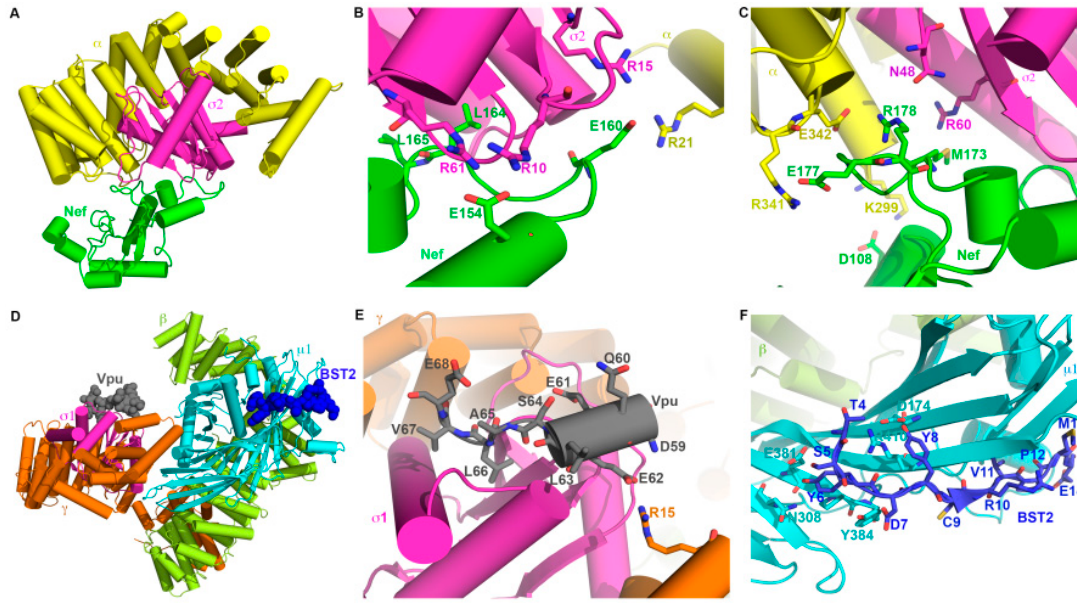
Figure 6. Structural interfaces between Nef and AP-2 (A–C) and Vpu, BST-2, and AP-1 (D–F). ( A ) Crystal structure of Nef bound to a hemi-complex of AP-2 containing two of the four AP subunits, α and σ 2 (PDB: 4NEE). α is shown in yellow; σ 2 is shown in magenta; and Nef is shown in green. ( B ) Interaction of Nef’s acidic leucine motif with α - σ 2. Nef L164 and L165 interact with σ 2 (magenta); Nef E160 interacts with R15 of σ 2 (magenta) and R21 of α (yellow); Nef E154 interacts with R10 and R61 of σ 2 (magenta). ( C ) Interaction of Nef distal C-terminal loop (173-178) with α - σ 2. Nef M173 interacts with R60 of σ 2 (magenta); Nef E177 interacts with R341 of α ; and Nef R178 interacts with E342 of α (yellow). ( D ) Crystal structure of the Vpu / BST2 / AP-1 complex (PDB: 4P6Z). All four subunits of the AP-1 complex are shown. Vpu (black) and the BST2 cytoplasmic domain (blue) are shown by spheres; only a small portion of the Vpu cytoplasmic domain is resolved. AP-1 subunits are colored: σ 1 (magenta), γ (orange), β 1 (green), and µ 1 (cyan). ( E ) Interaction of Vpu’s acidic leucine motif with γ - σ 1. Vpu residues are shown in black sticks and labeled; the key residues are E62, L66, and V67. This interaction is analogous to that of the Nef acidic leucine motif with α - σ 2 shown in panel B. R15 of γ is shown by orange stick. ( F ) Interaction of the BST-2 cytplasmic domain with the medium subunit of AP-1 ( µ 1). BST-2’s tyrosine motif—Y6xY8xxV—binds in a pocket of µ 1. BST-2-Y8 interacts with D174